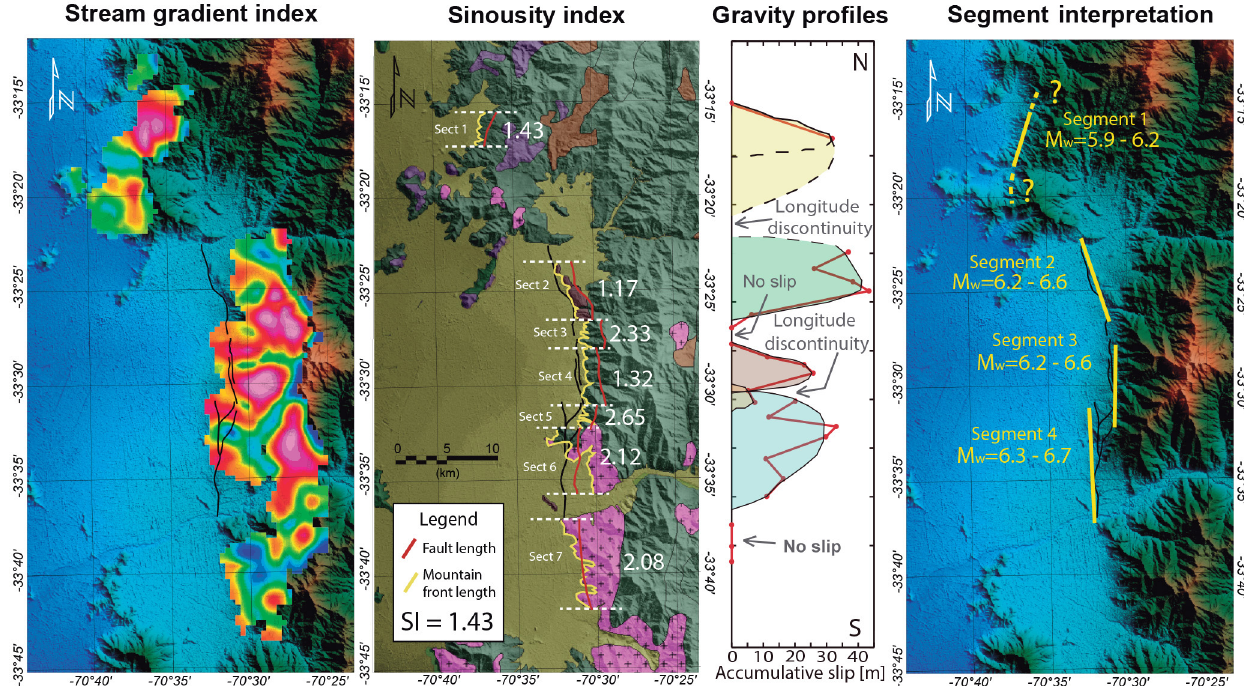
Figure 9. Interpretation of SRF subdomains or segments. It summarizes the results of the three methodologies used to define the length of the characteristic earthquake and the segments interpretation. The northern part of segment 1 has a high value of stream gradient index; additionally it has a low SI value and one gravity profile with ∼ 30m of cumulative slip. Segment 2 is spatially related to the central area with high values of stream gradient index. It also has a low SI value and several basement scarps observed in gravity profiles (shown in Fig. 6) with a cumulative slip of 40m in mean. Segment 3: separated from segment 2 by high a SI value and without gravity anomalies in two profiles; it presents well-developed surface scarps. Still located in the central high SL index area with a SI value close to 1 and several gravity profiles with basement scarp signature. The TEM profile is also shown here (Fig. 1 and Supplement S1). Segment 4 is separated from segment 3 by a longitude discontinuity. This segment is still located in the central high SL index area and has several gravity profiles with basement scarp signature. The high value of the SI is interpreted by a section where this methodology is not applicable because the fault is not at the